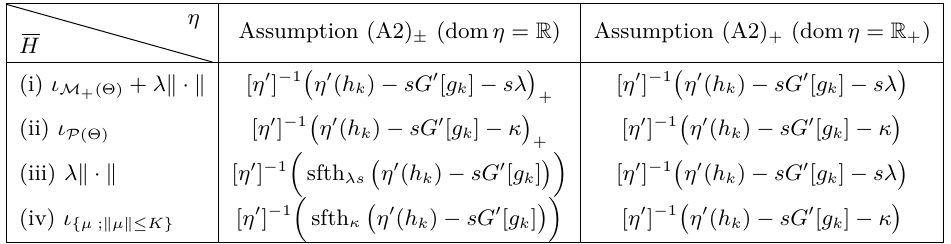
Table 1 Update step h k +1 for APGM, and PGM (when f k = g k = h k ) where sfth κ ( a ) = sign( a )( | a